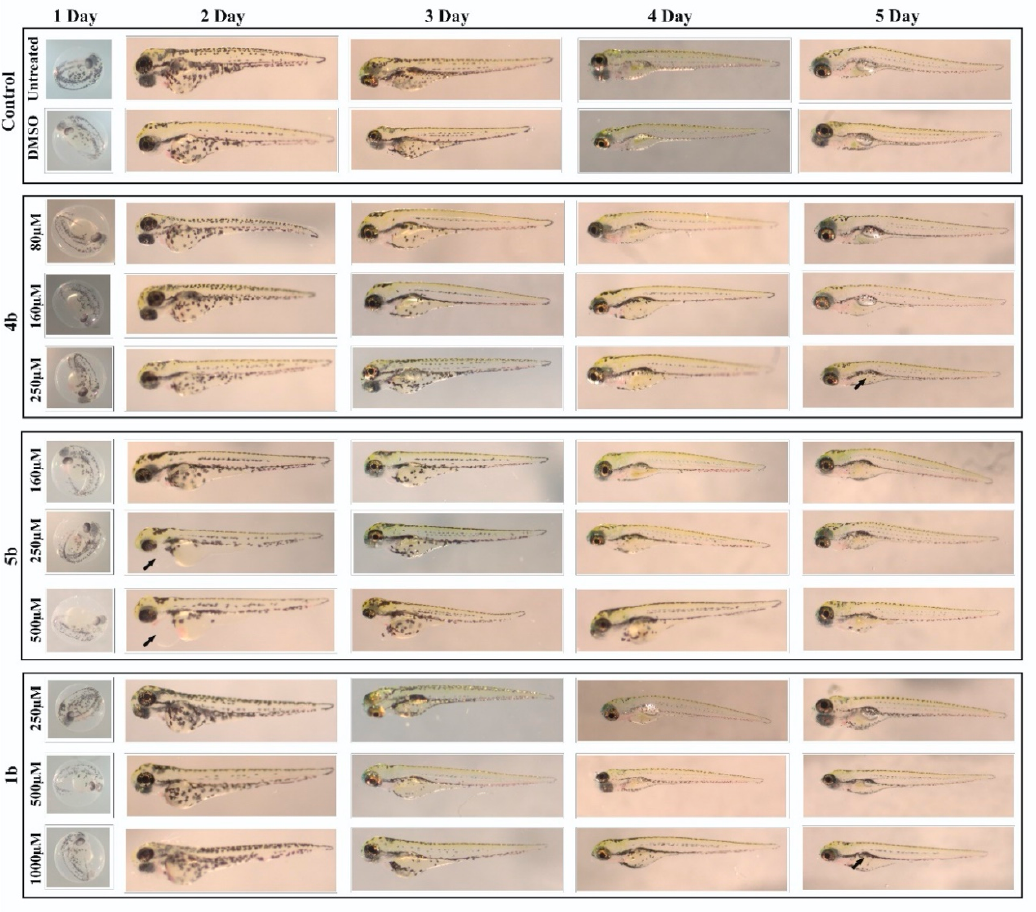
Figure 4. Images of zebrafish larvae in the control and prodrug-treated groups. Representative images of 2–5 dpf zebrafish larvae exposed to different concentrations (80 µM–1000µM) of 1b , 4b and 5b . The upper panel shows images for normal development of zebrafish larvae in the control group (not treated with inhibitors) and the 1% dimethyl sulfoxide (DMSO)-treated group. The lower panel shows the larvae treated with concentrations of the compounds at which they induced minimal or no phenotypic defects. Prodrug 4b showed (arrow) an absence of a swim bladder at a 250-µM concentration at 5 days. Prodrug 5b induced edema (arrow) as early as 2 days post exposure to the compound. Compound 1b showed an absence of a swim bladder (arrow) at a 1000-µM concentration at 5 days.